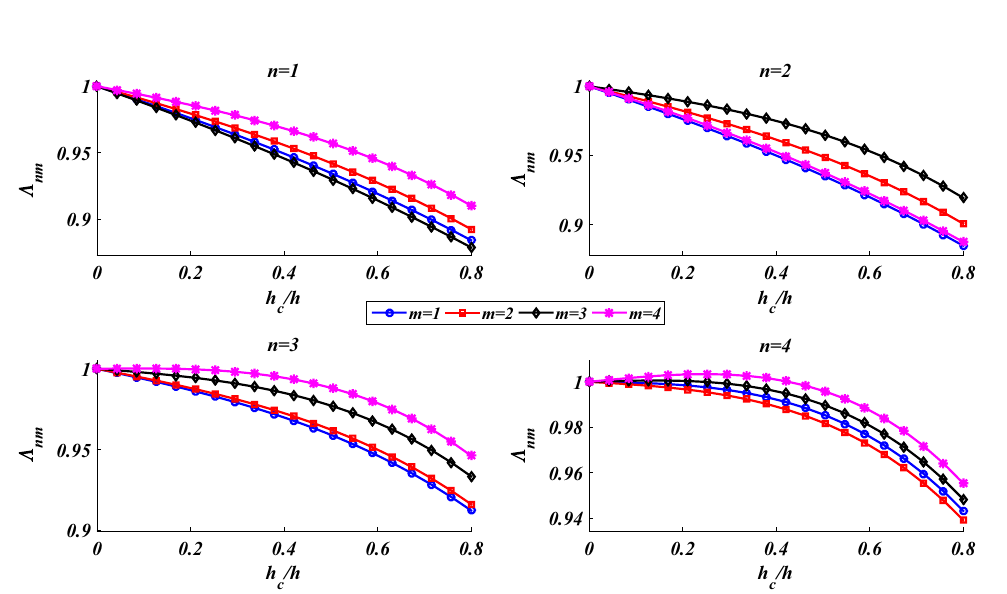
Figure 6. Dependency of the natural frequencies on the thickness of the FGP